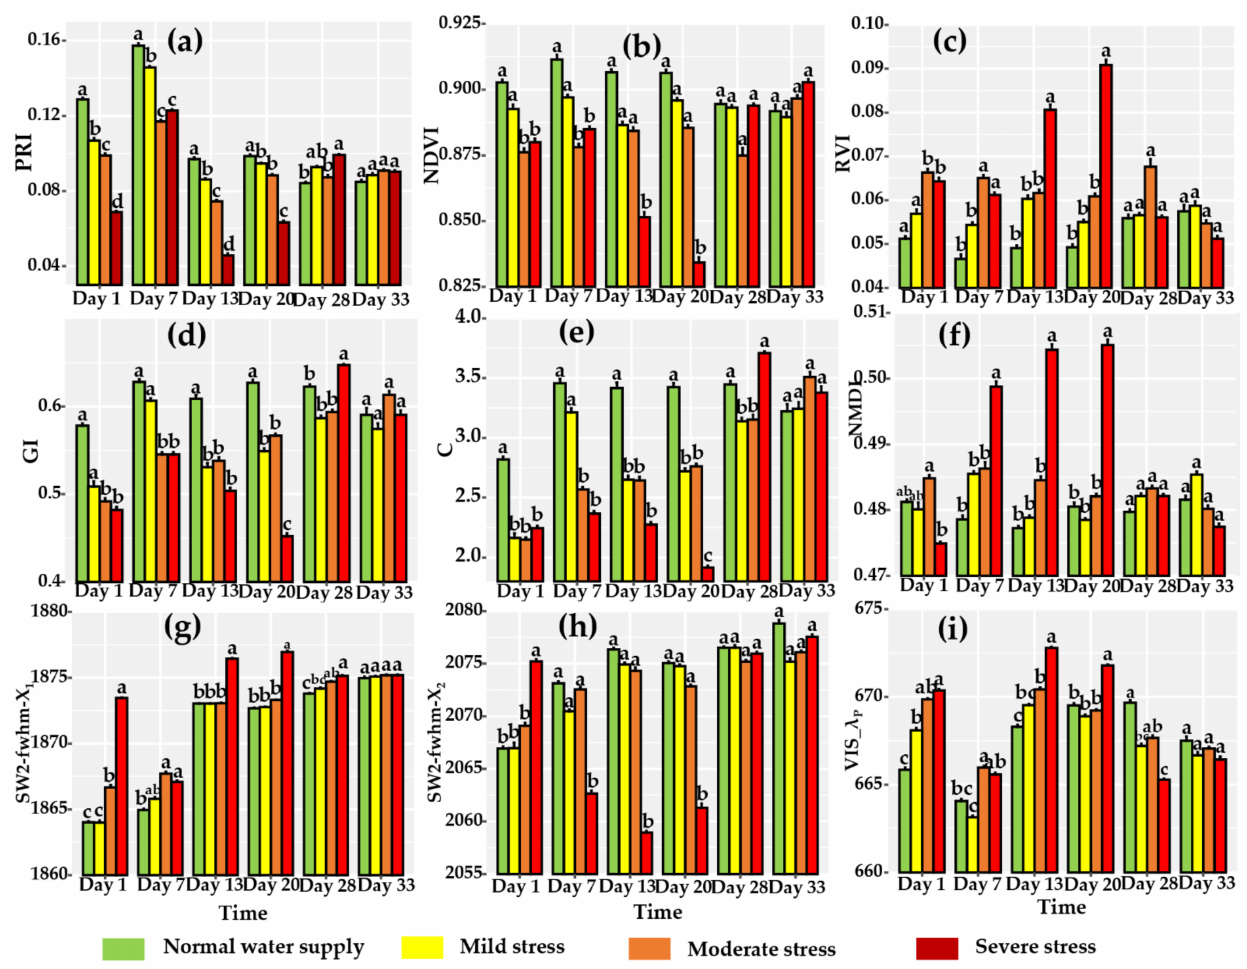
Figure 6. Performance of spectral parameters for revealing the difference of four drought treatments. ( a – i ) represent PRI, NDVI, RVI, GI, C, NMDI, SW2-fwhm-X 1 , SW2-fwhm-X 2 , and VIS- λ P , respectively. Significant differences are indicated by different letters on the histogram at the same